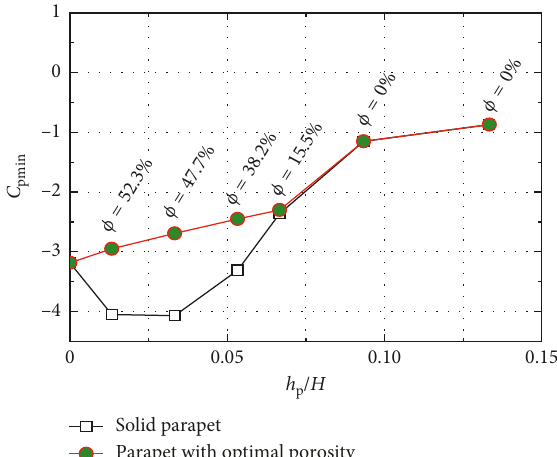
Figure 10: Comparison of the highest mean suctions between roof models with solid parapets and the parapets having optimal